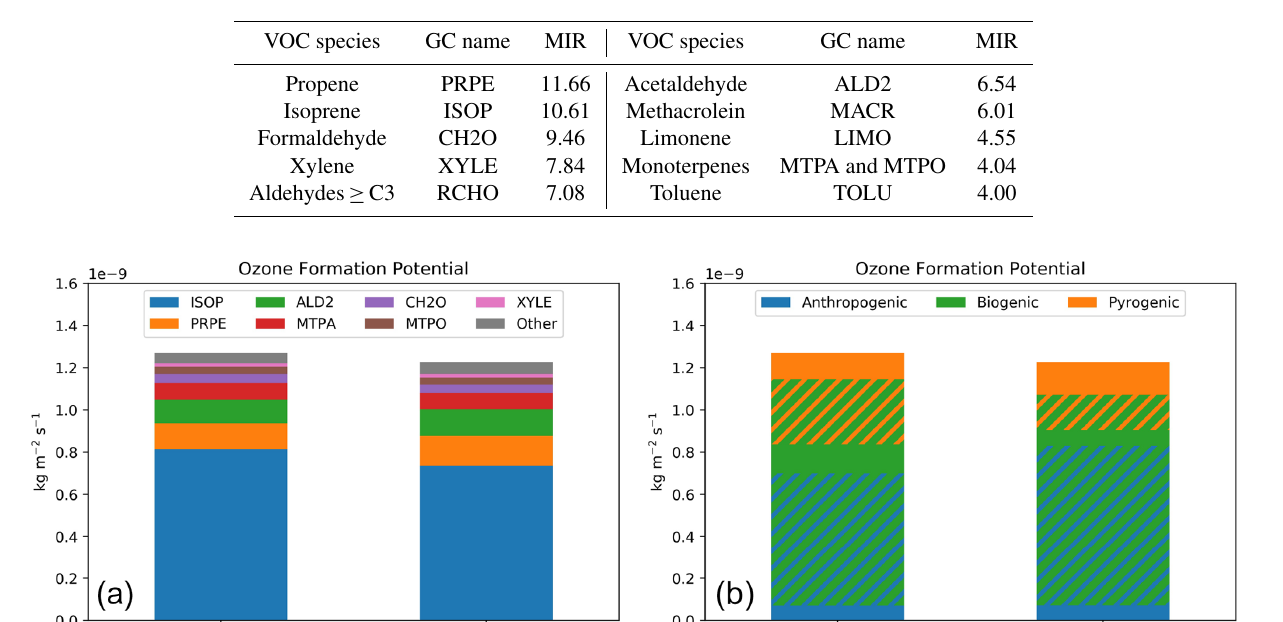
Table 1. Emitted VOCs in GEOS-Chem with the highest assigned MIR (grams of ozone formed per gram of VOC emitted). Adapted from Carter (2010).